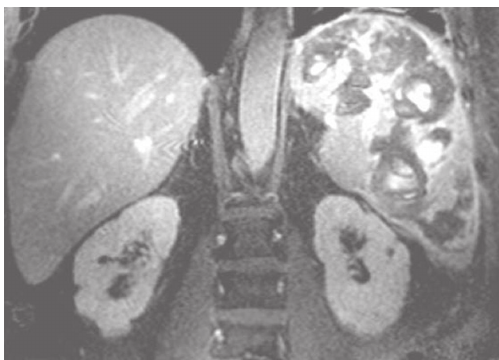
Figure 3: Coronal postcontrast MR image showing splenomegaly with multiple intensely enhancing masses.